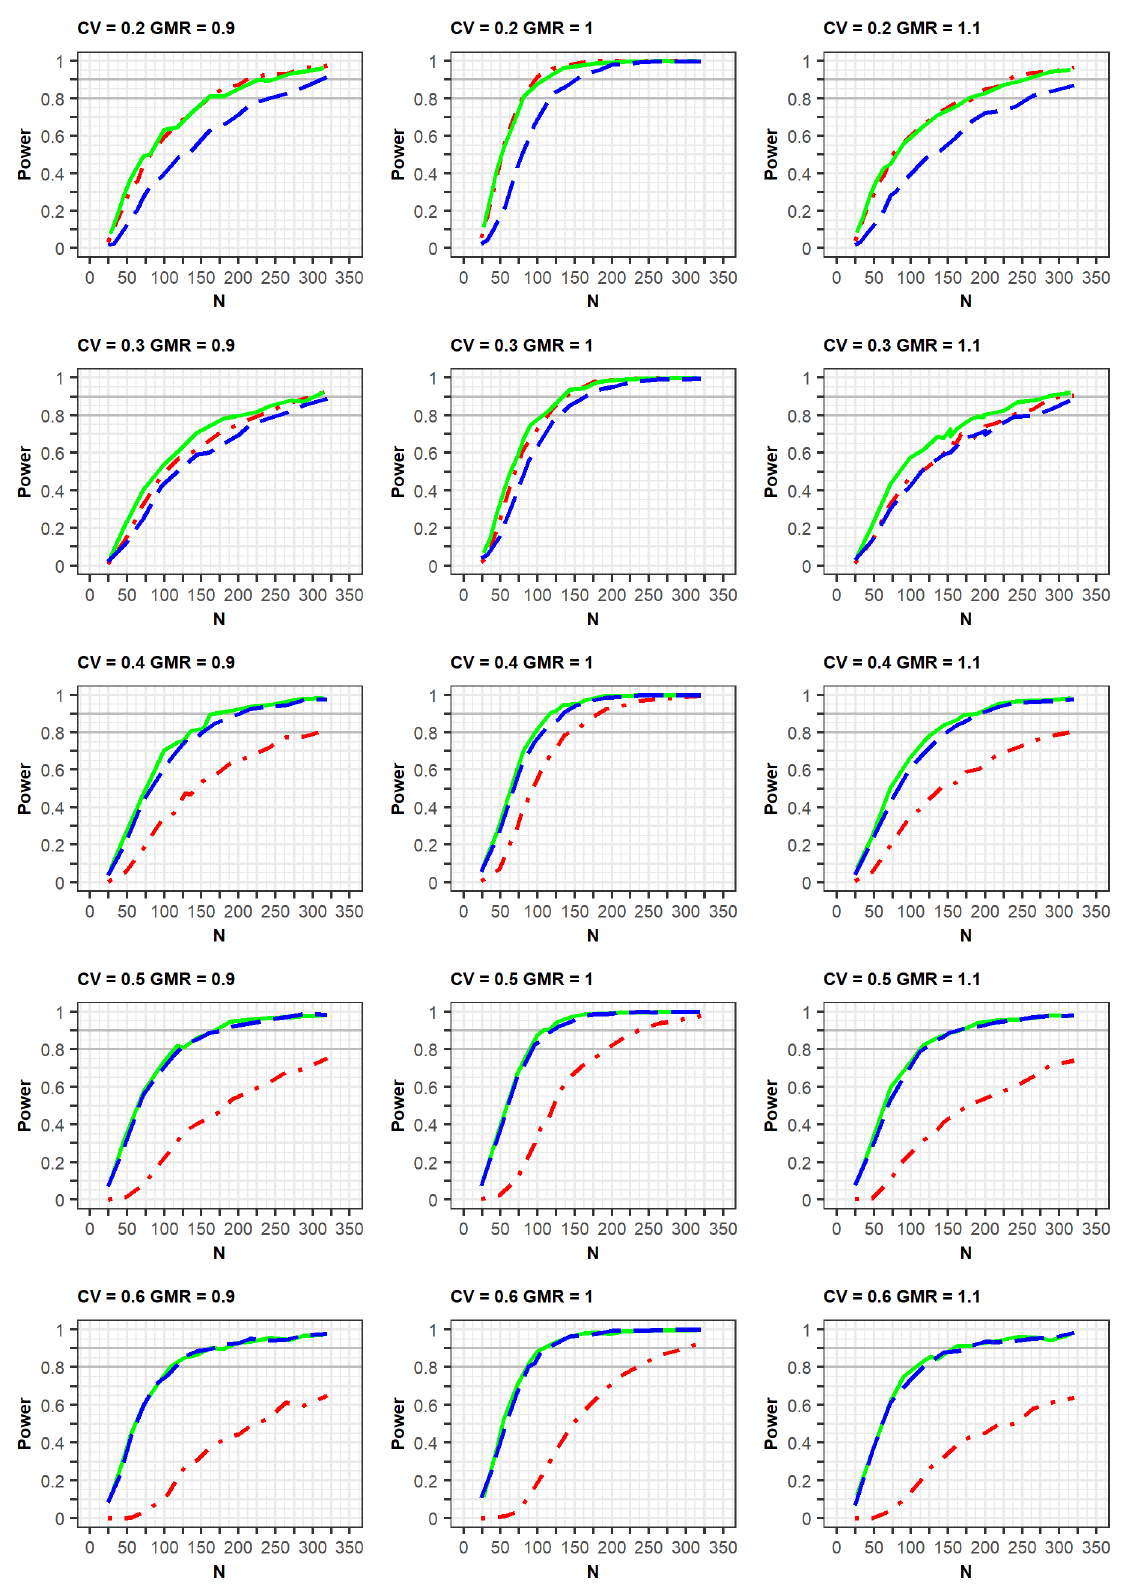
Figure 3. Comparison of power calculated as per the FDA guidelines among clinical trial designs: 2 × 2 design (red dot–dashed line), 3 × 3 design (green solid line), and 2 × 4 design (blue long–dashed line). The x-axis and y-axis represent the total number of trials (N) and statistical power, respectively.